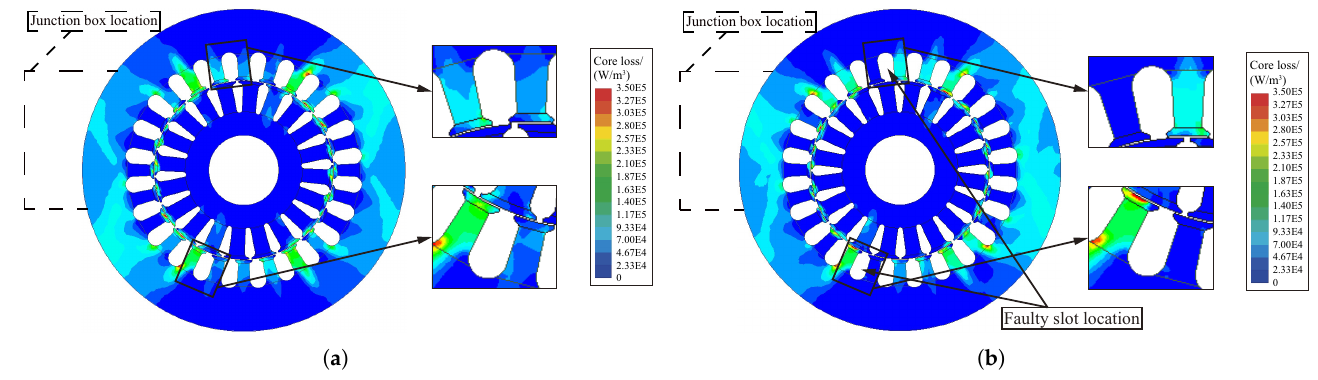
Figure 6. Core loss distribution of normal and faulty motors. ( a ) Normal. ( b ) Forty-five-turn